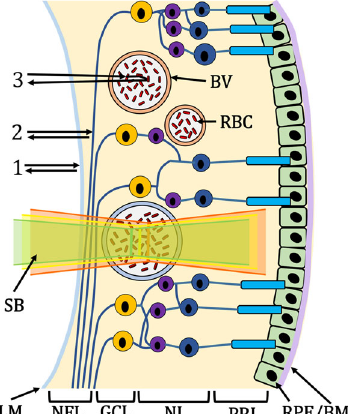
Fig. 1 Schematic of vis-OCT photon scattering within the retina. Illustration of the human retina composed of inner-limiting-membrane (ILM), Retinal Nerve Fiber Layer (NFL), blood vessels (BV; red is the artery, blue is the vein), red blood cells (RBC), ganglion cell layer (GCL), nuclear layers (NL) representing the inner nuclear layer to the outer nuclear layer, photoreceptor layers (PRL) containing rods and cones, and the retinal pigment epithelium and Bruch ’ s membrane (RPE/BM). Group 1 highlights the photon path of a specular re fl ection; 2 highlights the photon path of backscattering without blood attenuation; 3 highlights the photon path of backscattering from red blood cells. A scanning beam (SB) is composed of visible-light wavelengths (green, yellow, and red illustrate different spectral bands of the